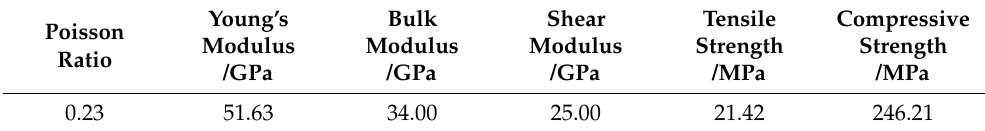
Figure 14. 1/2 numerical model. Table 3. Material parameters of the numerical model.